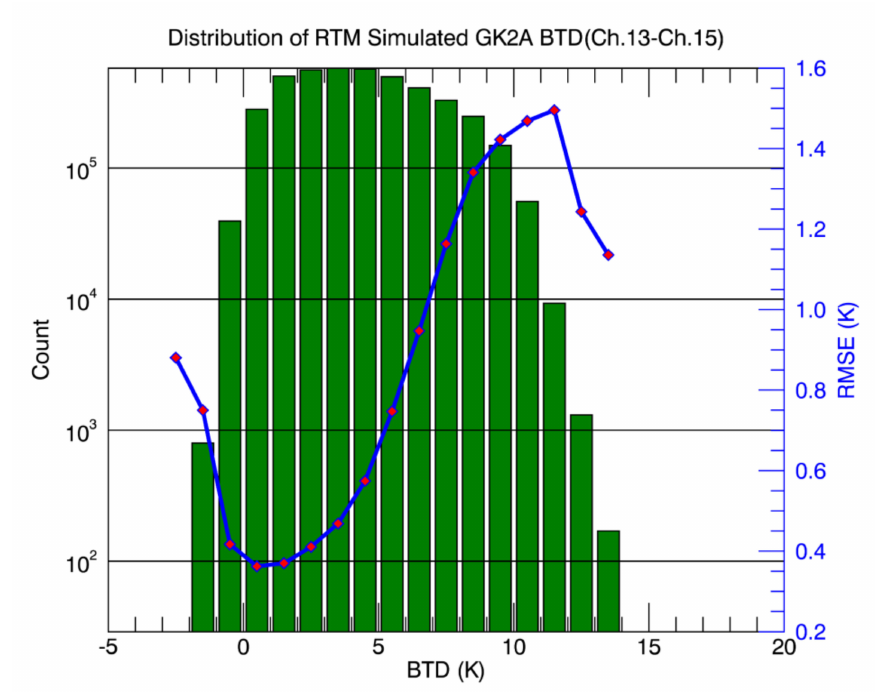
Figure 4. Distribution of radiative transfer model simulated brightness temperature di ff erences between channel 13 and channel 15 of GK2A (green histogram) and their root mean square error (RMSE) values (blue